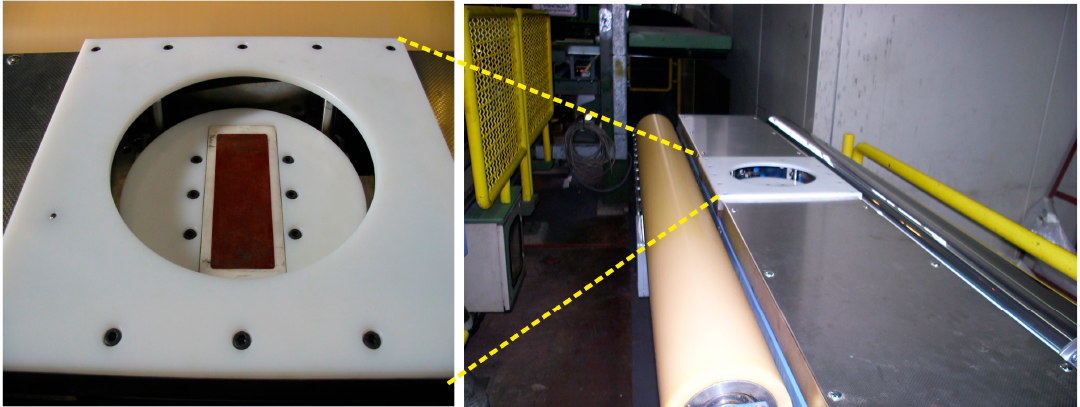
Figure 9. Rotatable 3MA probe head holder and table carrier of the 3MA inline strip testing system.